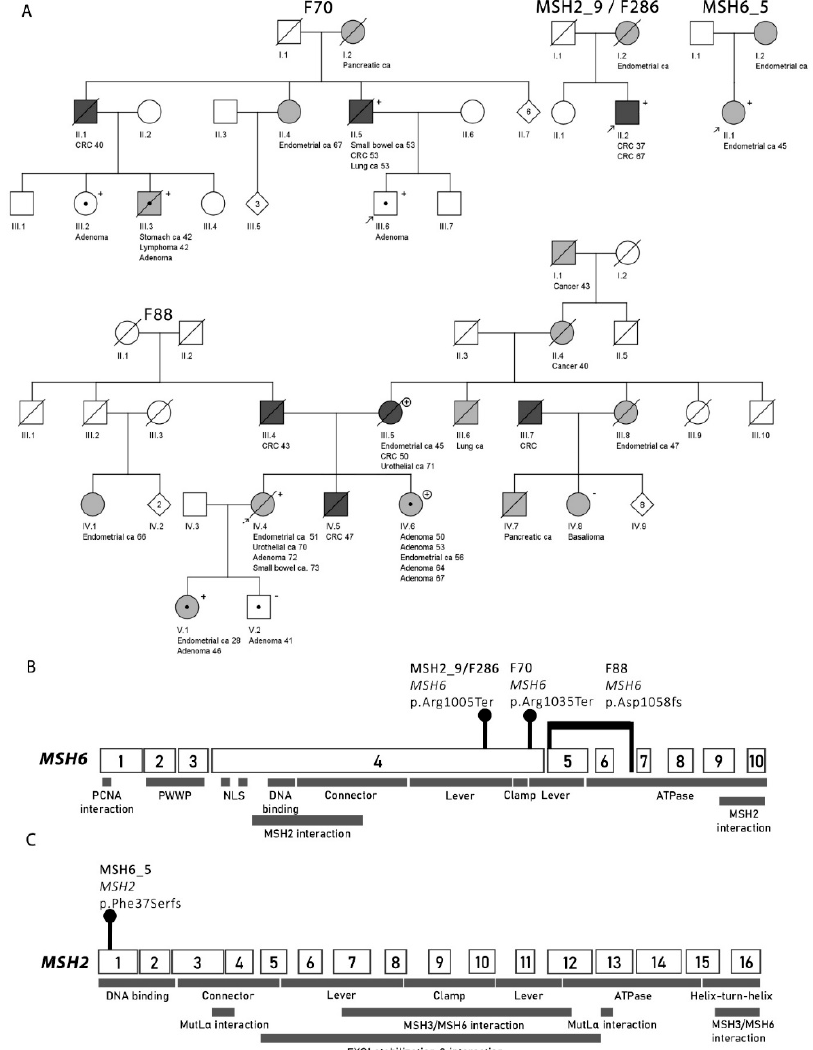
Figure 3. The four families that revealed a germline mutation in a mismatch repair (MMR0 gene not expected from the IHC pattern. ( A ) Pedigrees generated with Pedigree Chart Designer. Numbers below the symbols are patient identifiers. Arrow denotes the index person. Tumor manifestations and age at diagnosis (years) are given below the patient symbol. Carrier status for the germline mutation (of MSH6 or MSH2 , see parts ( B , C ) below) specific for each family is shown ( + , heterozygous carrier; − , non-carrier). F88 additionally had a branch with a germline deletion of MLH1 exon 16 (plus sign within a circle indicates carriers of this deletion). ( B ) Locations of the MSH6 germline mutations relative to the functional domains of the MSH6 protein in the MSH2-deficient families F70, F88, and MSH2_9 / F286. Exonic structure of MSH6 is also shown. ( C ) Location of the MSH2 germline mutation of the MSH6-deficient case MSH6_5 against the gene and protein structure of MSH2